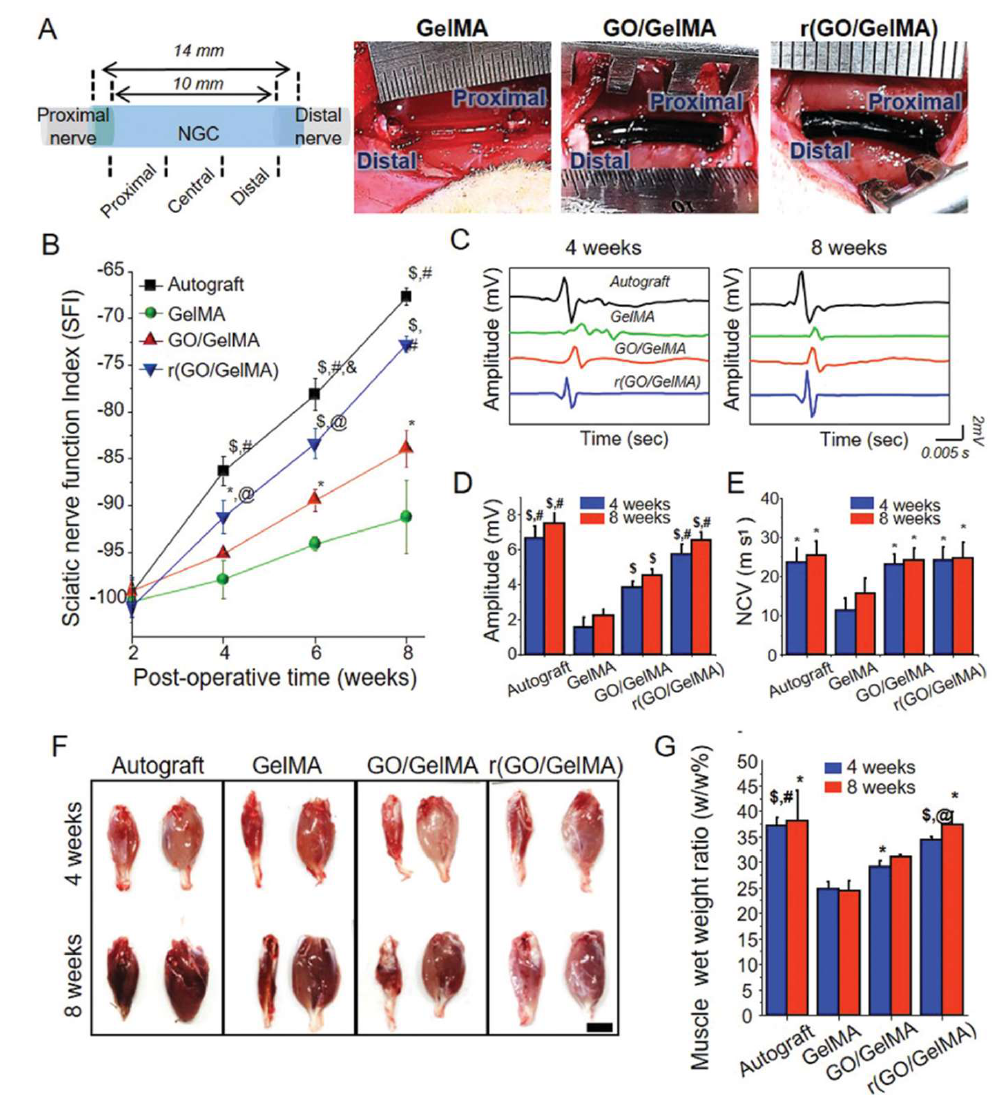
Figure 5. In vivo implantation of NGCs and functional recovery. ( A ) NGCs were implanted in a 10 mm gap of the sciatic nerve. ( B ) SFI of different groups at predetermined time points. ( C ) Comparison of electrophysiological recordings of compound muscle action potentials (CMAPs) for various implanted NGCs and autografts. ( D ) Onset–to–peak amplitude and ( E ) NCV of each group. ( F ) Images of muscles and ( G ) muscle wet weight ratio in each group. Scale bar: 25 mm. *, p < 0.05 compared to GelMA at the same week. $, p < 0.01 compared to GelMA at the same week. @, p < 0.05 compared to GO/GelMA at the same week. #, p < 0.01 compared to GO/GelMA at the same week. &, p < 0.05 compared to r(GO/GelMA) at the same week. (For interpretation of the references to color in this figure legend, the reader is referred to the web version of this article.) This figure was published in [56]—copyright, John Wiley and Sons (2020). Permission to share the material has been granted.